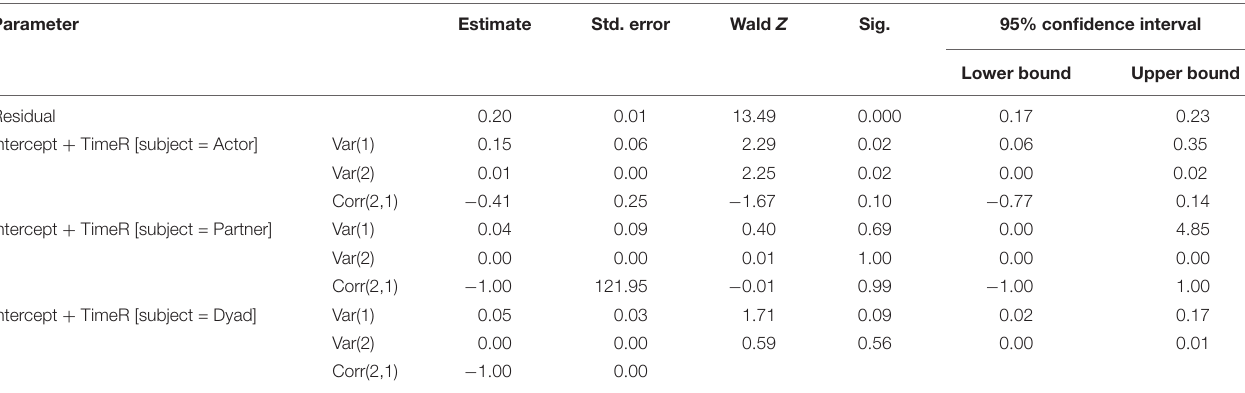
TABLE 6 | Estimates of covariance parameters negative affect (Study 2; k = 648 observations).